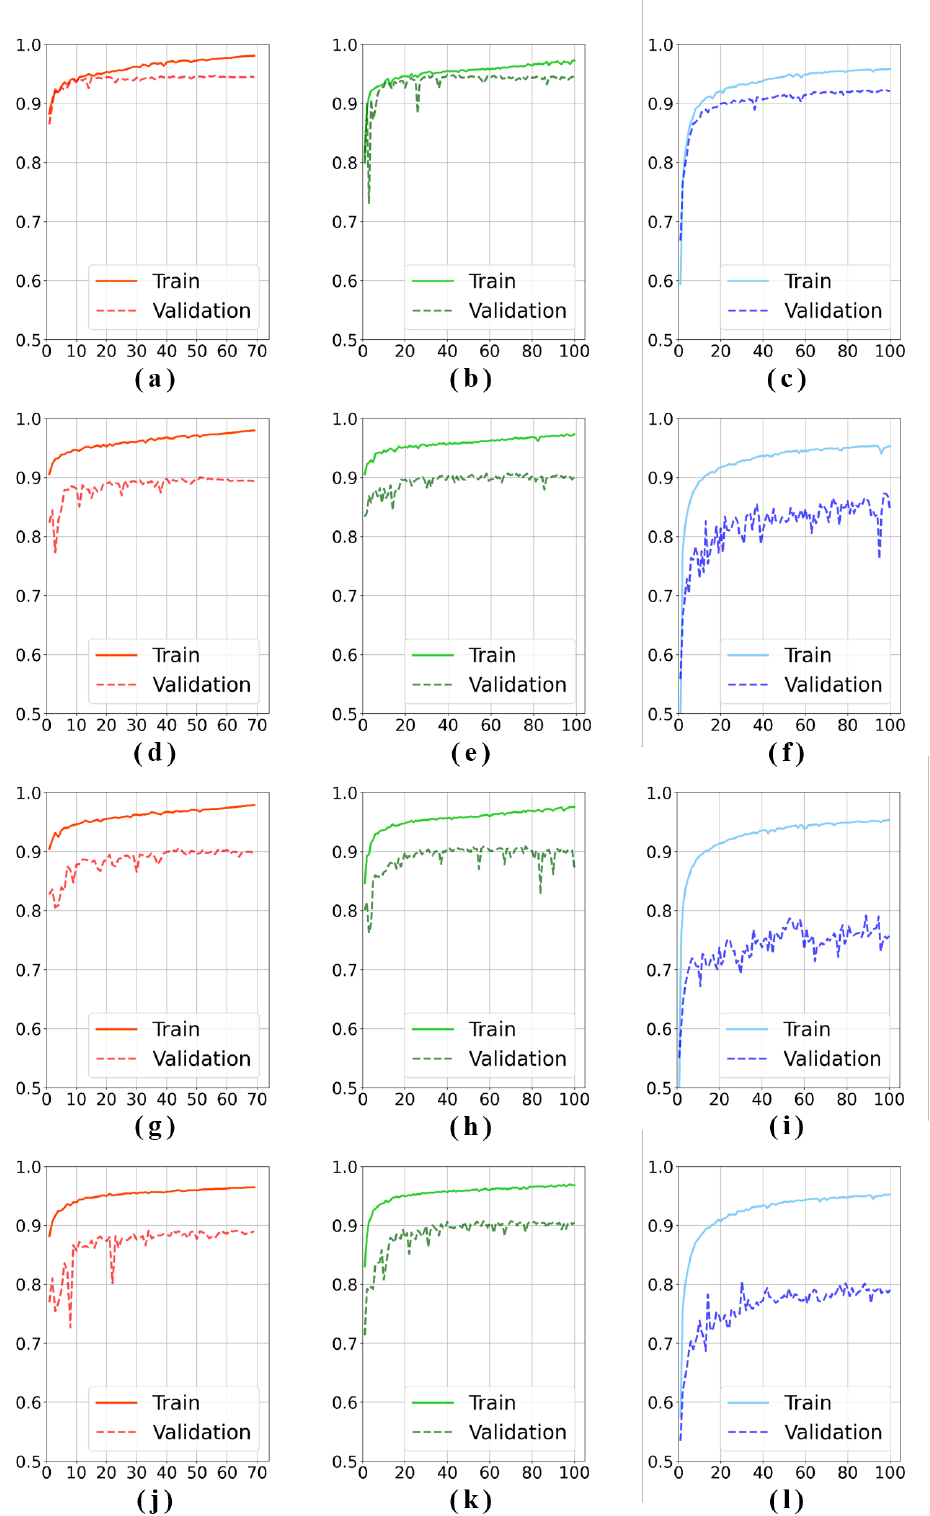
Figure 6. Train (solid) and validation (dashed) learning curves of our experiments. The x -axis and y -axis mean epoch and validation MIoU, respectively. Each column corresponds to DeepLab V3+, U- Net, and SegNet. Each row corresponds to RGB images, RGB with RE, RGB with NIR, and RGB with RE and NIR, respectively. Note that the x -axis limits of the first and other columns are set